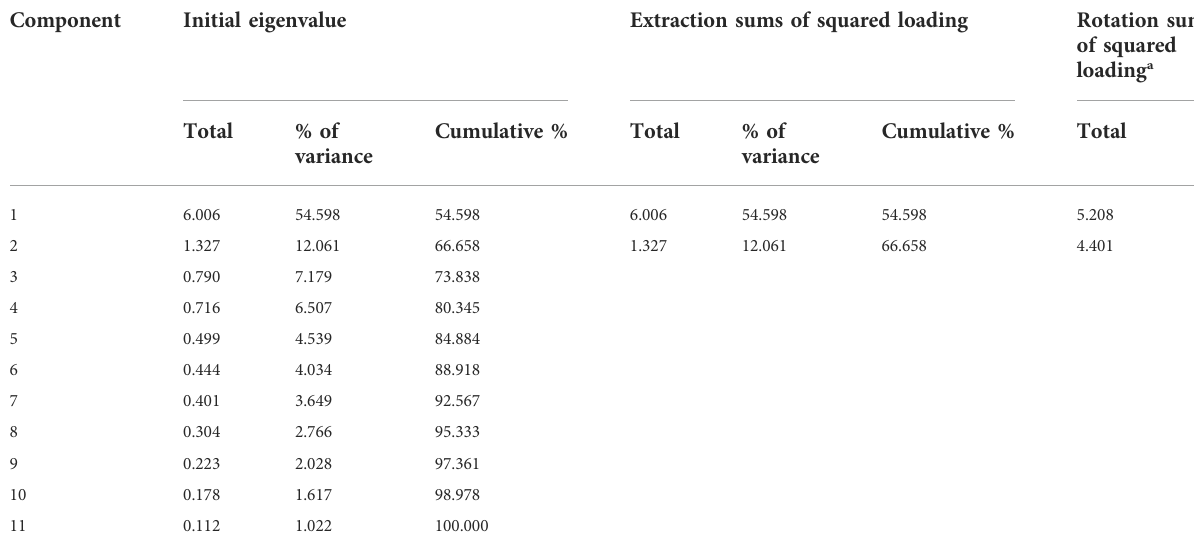
TABLE 7 Total variance explained by components of key